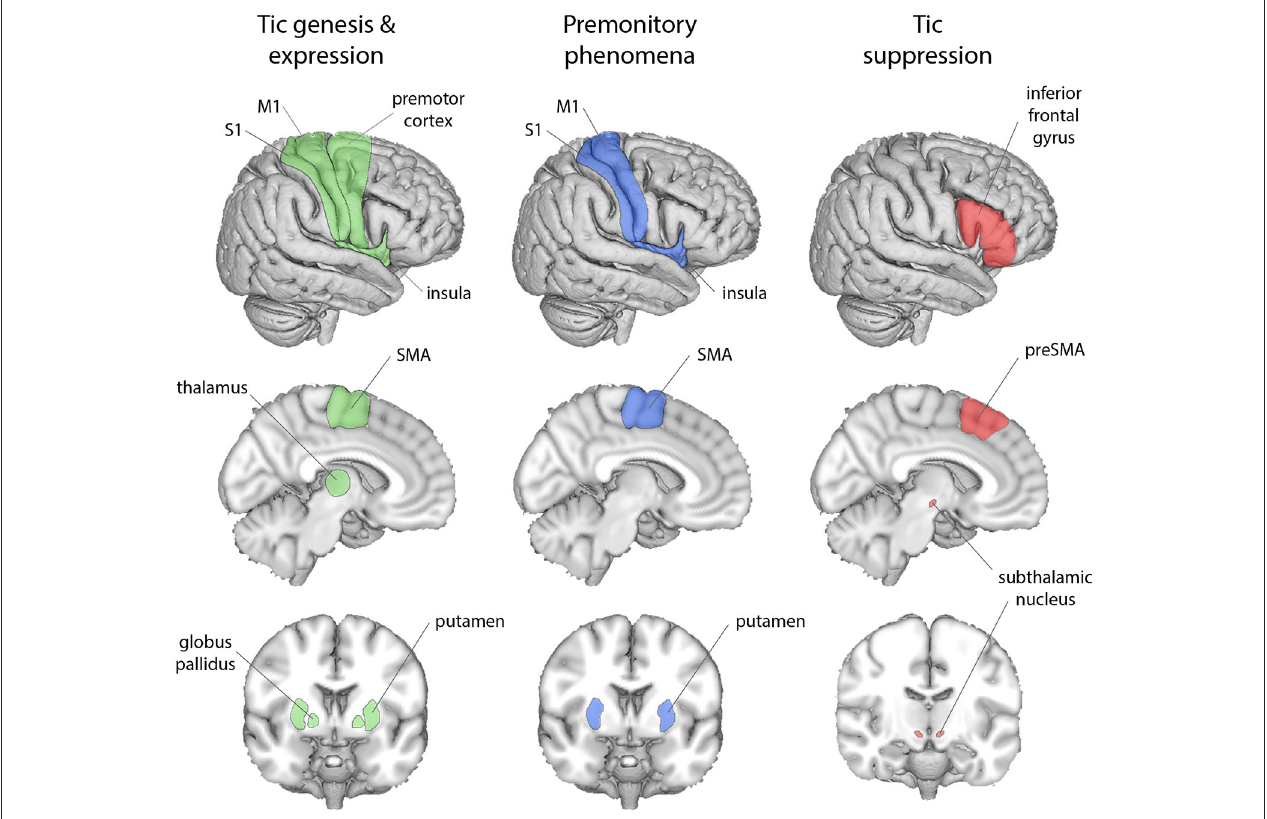
FIGURE 1 | Cortical and subcortical regions associated with the phenomenological features of TS. Tic genesis and expression (green) is associated with premotor cortex, SMA, insula, M1, S1, the putamen, globus pallidus, and thalamus; premonitory sensations (blue) with the SMA, insula, M1, S1, and the putamen; tic suppression (red) with the inferior frontal gyrus, preSMA, and the subthalamic